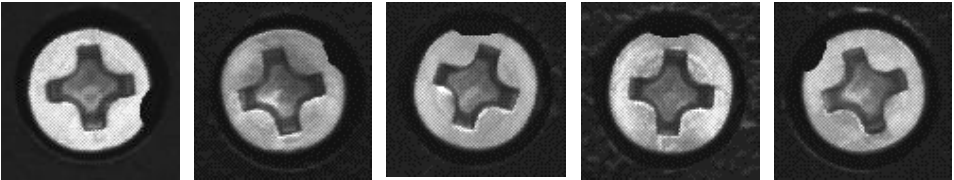
Figure 5. Stripped screws.